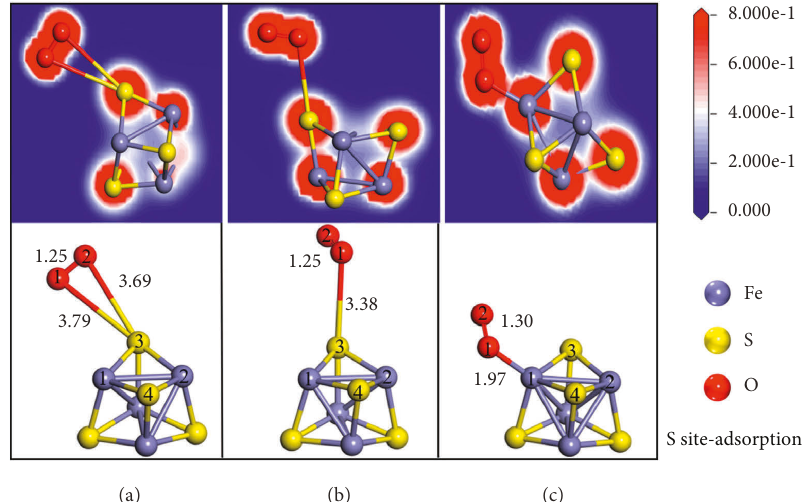
Figure 4: Adsorption structures of O 2 on S sites on Fe 4 S 4 clusters and the charge density of each adsorption structure. The bond lengths in the figure are in ˚A, 1 ˚A � 1 ∗ 10 − 10 m; the blue part of the charge density diagram indicates no charge aggregation, and the red part indicates charge aggregation.